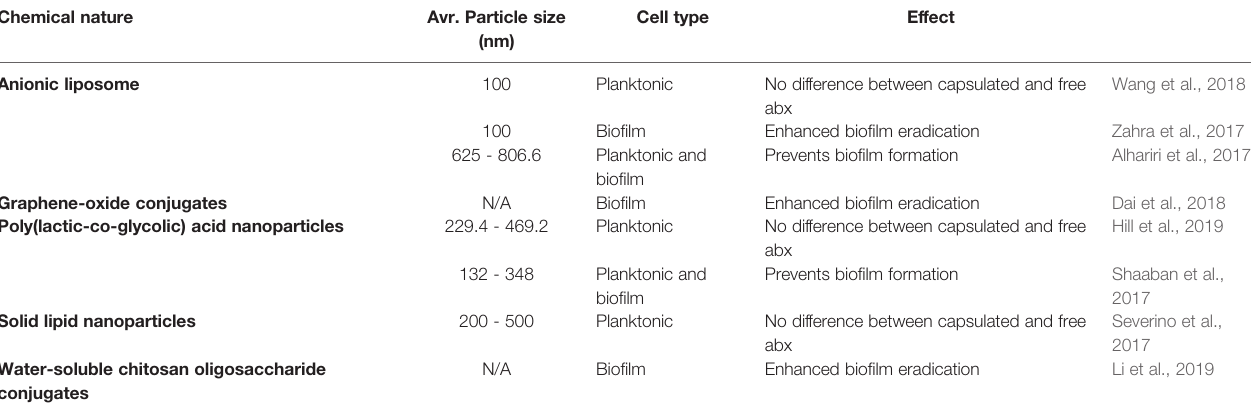
TABLE 1 | Recent efforts in the design of drug delivery methods for anti-pseudomonal therapies. Chemical